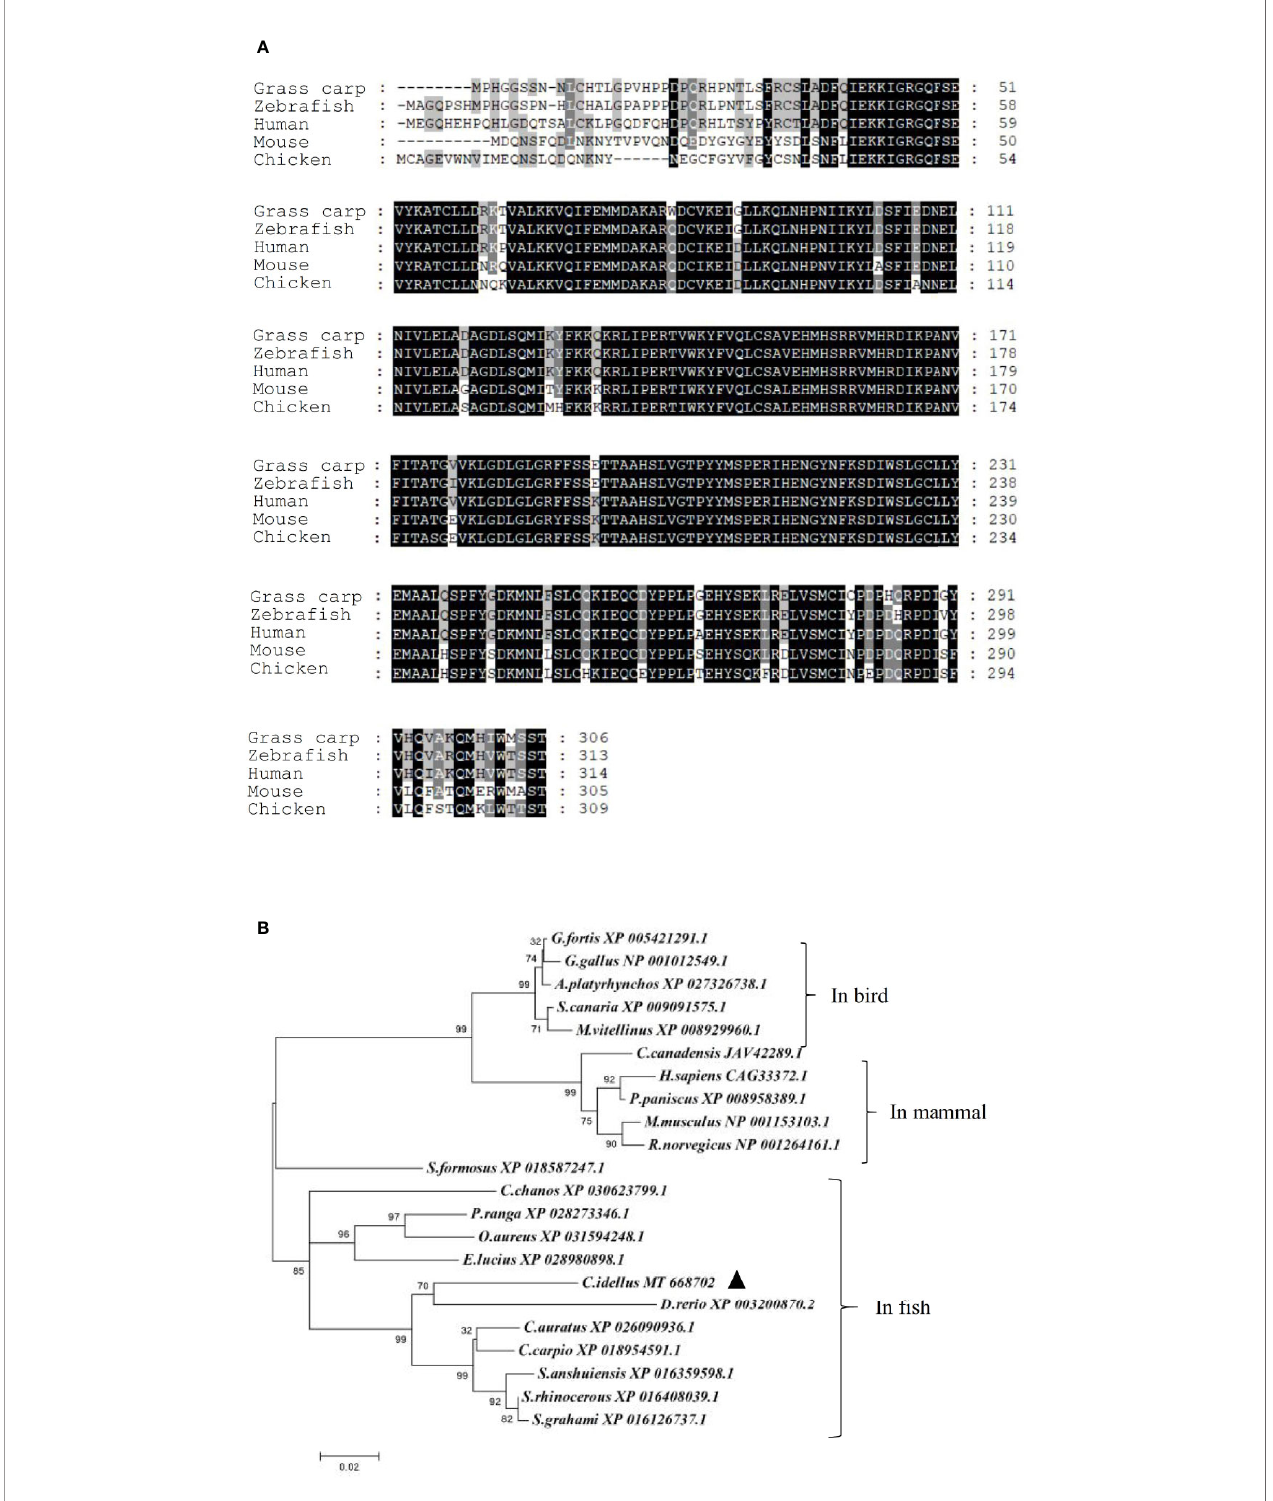
FIGURE 1 | Amino acids sequences alignment and phylogenetic tree of NEK6. Amino acids sequences of grass carp NEK6, zebra fi sh NEK6, human NEK6 and mouse NEK6 were aligned by Gene doc server (A) . The phylogenetic tree of NEK6 in bird, mammals and fi sh was analyzed by MEGA X (B)